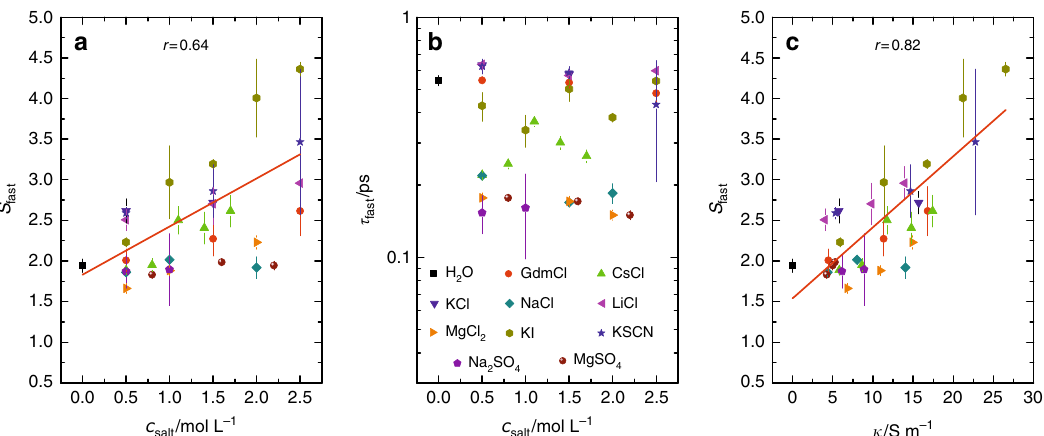
Fig. 3 Effect of the ion type on the spectroscopically observed fast dynamics. a Amplitude, S fast , of the fast mode as a function of salt concentration, c salt . The variation of S fast with c salt largely varies with the salt type. The solid line shows a linear fi t to all data, with a Pearson ’ s correlation coef fi cient of r = 0.64. b Relaxation time of the fast Debye mode as a function of salt concentration. c S fast as a function of electrolyte conductivity, κ . The solid lines show a linear fi t to all data, with a Pearson ’ s correlations coef fi cient of r = 0.82, demonstrating the scaling of S fast with conductivity. Error bars in all panels correspond to the standard deviation within six independent